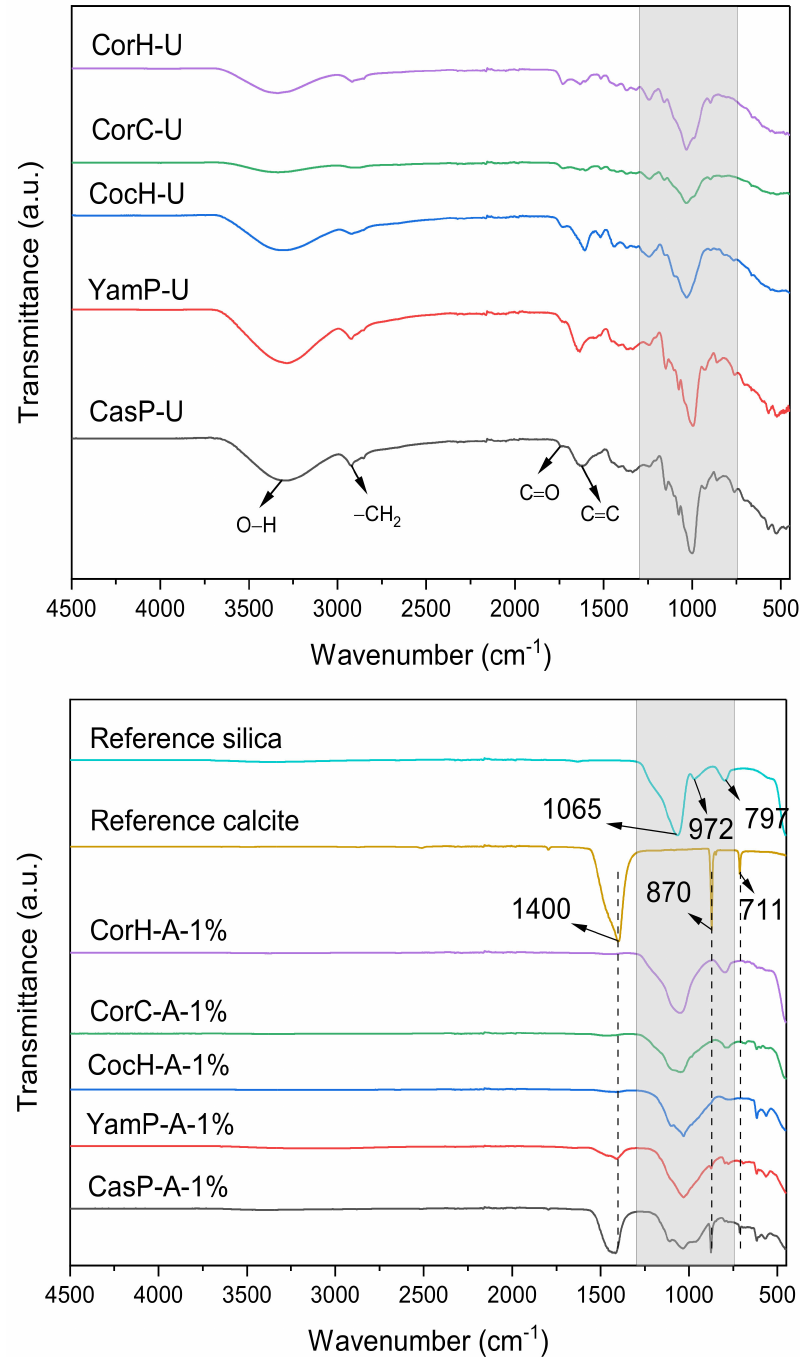
Figure 3. The evolution of the main functional groups in raw biomass ( upper ) and ashes of 1 w / v % biomass fuels ( bottom ). Ashes were generated at 600 ◦ C and compared with the FTIR of commercial calcite and silica